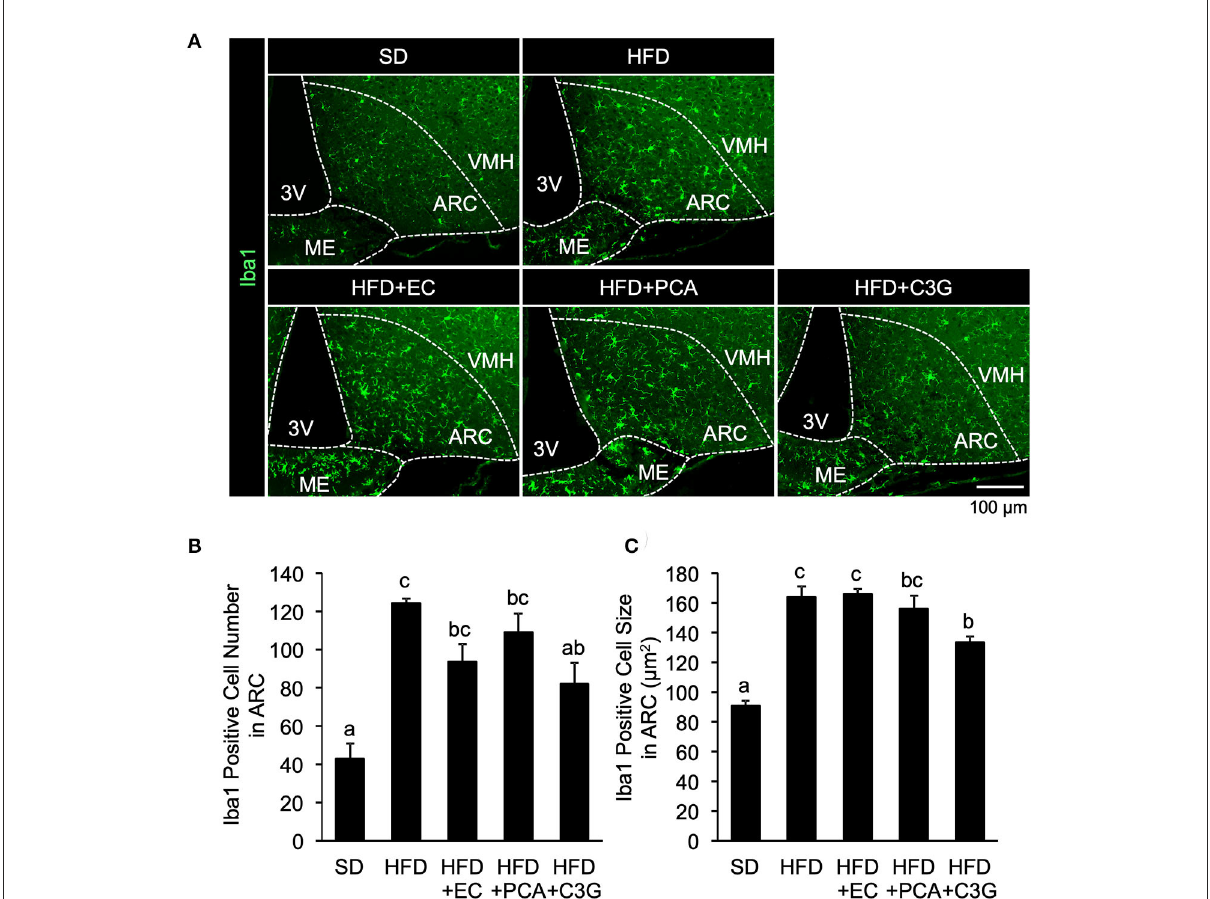
FIGURE6 Effects of three fractions derived from BE on the HFD-induced hypothalamic gliosis of mice. (A) Sections of the mediobasal hypothalamus (10- µ m-thick), immunofluorescence-stained for ionized calcium-binding adapter molecule 1 (Iba1) in mice fed standard diet (SD), high-fat diet (HFD), HFD + EC, HFD + PCA, or HFD + C3G for 4 weeks. The third ventricle (3V), median eminence (ME), hypothalamic arcuate nucleus (ARC), and ventromedial hypothalamic nucleus (VMH) of the left side of the brain of mice from each group are shown. Quantification of (B) the number and (C) size of Iba1-positive cells in the ARC. The cell number and size in the ARC of the left and right hemispheres of the brain were measured and mean values were calculated. Data shown are mean ± SE ( n = 3). Different letters represent significant differences among the three groups by each experimental period by Tukey-Kramer honestly significant difference test ( p <